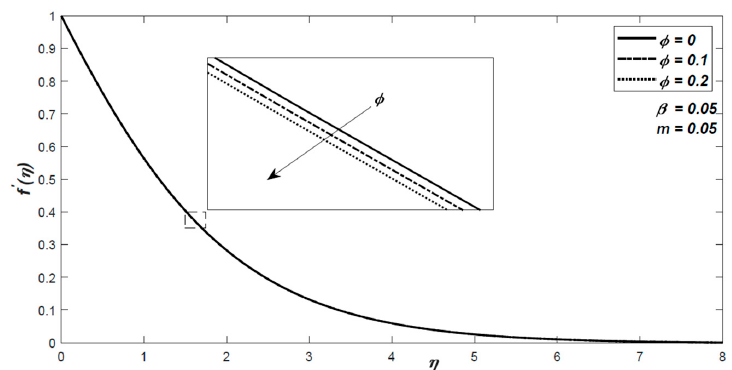
Figure 8. The variation of the nondimensional velocity for different values of volume fraction φ .